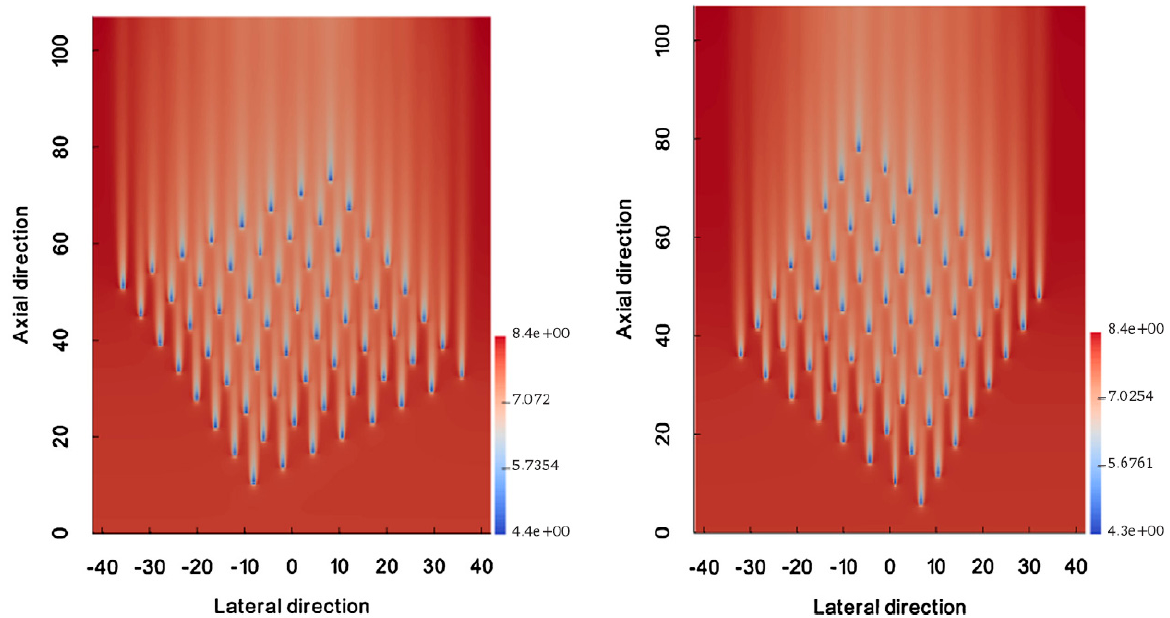
Figure 7. Velocity variations around two different arrangements of offshore wind turbines farms (Adapted with permission from ref. [27]. Copyright 2018 Energy Conversion and Management).